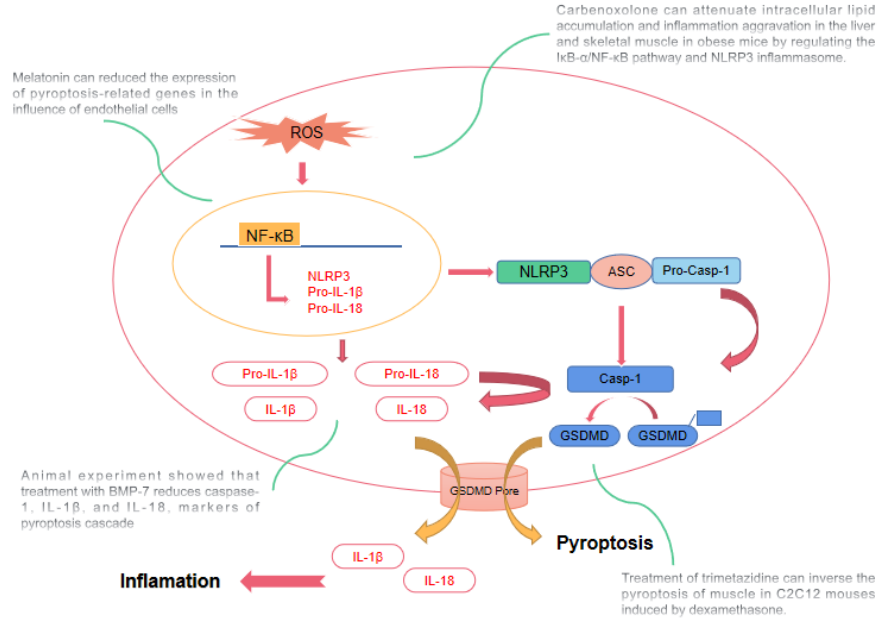
Figure 3. Possible interventions may focus on interfering with the signaling pathway of pyroptosis. a. Melatonin can reduce the expression of pyroptosis-related genes in the influence of endothelial cells. b. Treatment with bone morphogenetic protein 7 (BMP-7) reduces caspase-1, Interleukin-1 β (IL-1 β ), and Interleukin-18 (IL-18), markers of pyroptosis cascade. c. Carbenoxolone can attenuate intracellular lipid accumulation and inflammation aggravation in the liver and skeletal muscle in obese mice induced by the high-fat diet by regulating the IkappaB-alpha (I κ B- α )/ nuclear factor— kappaB (NF- κ B) pathway and the nod-like receptor 3 (NLRP3) inflammasome. d. Treatment of trimetazidine can reverse the pyroptosis of muscle in C2C12 mouses induced by